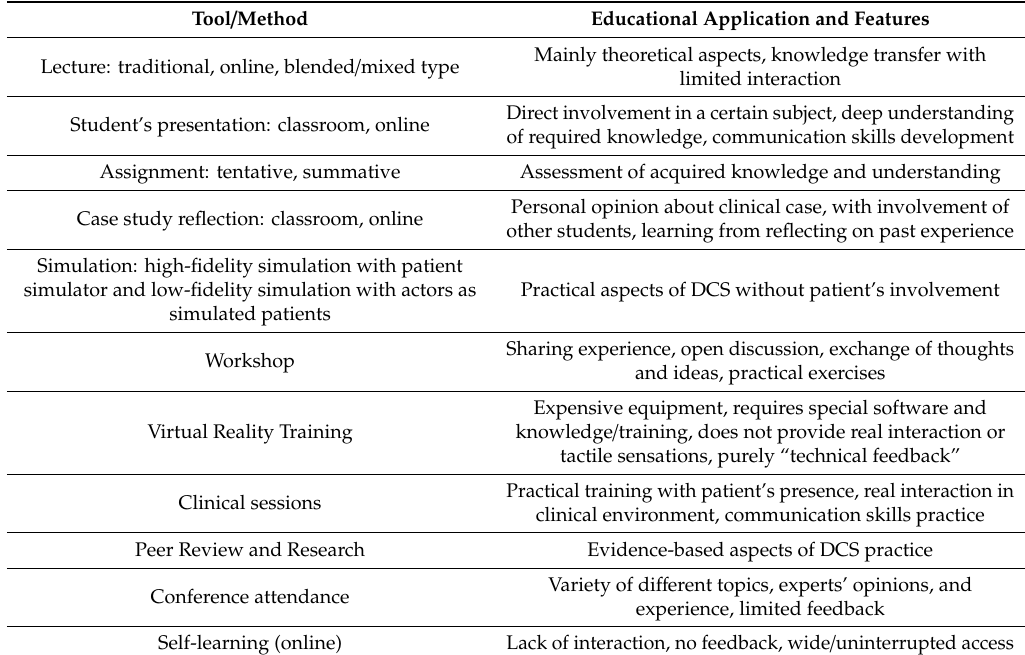
Table 2. Educational tools and various types of didactic methods used directly in DCS